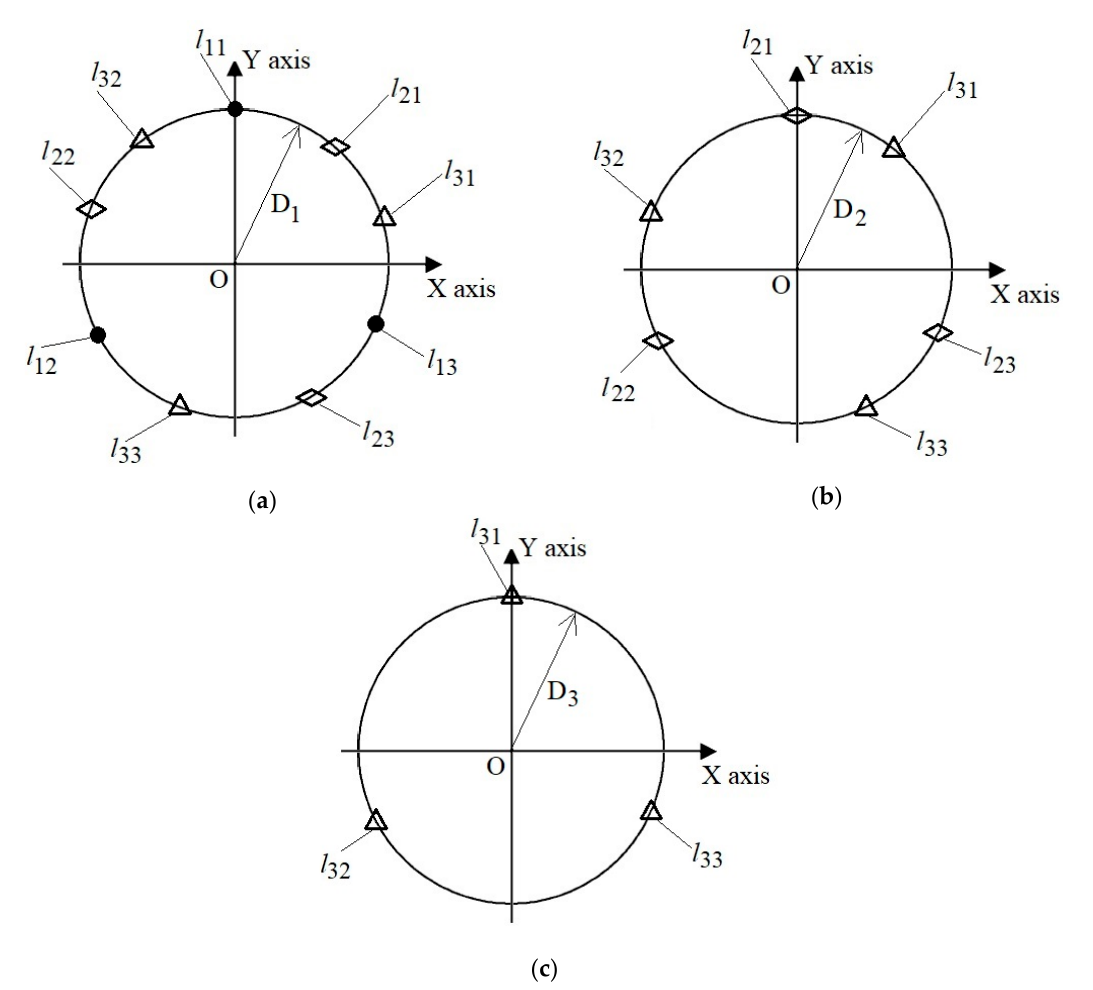
Figure 17. Robot cables’ hole positions on the connecting disks: ( a ) Cables’ hole positions on the first segment connecting disk in the first segment coordinate system; ( b ) cables’ hole positions on the second segment connecting disk in the second segment coordinate system; ( c ) cables’ hole positions on the third segment connecting disk in the third segment coordinate system.